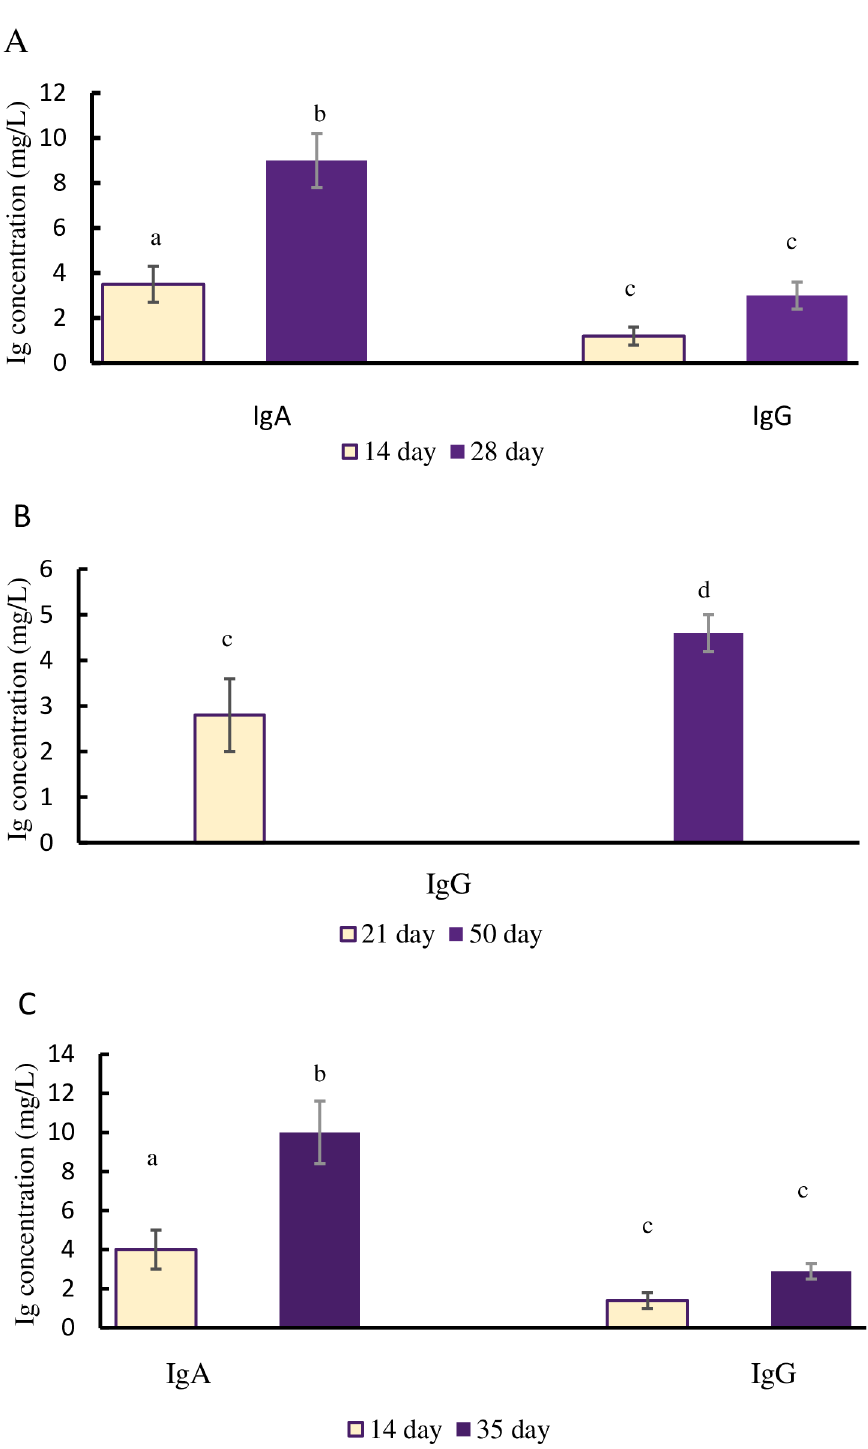
Fig 4. The immune response in mice after vaccination with live vaccine. Mice were vaccinated vaginally (A), per os (B) nasally, (C) with E . faecium L3Bac +. The Bac-specific secretory IgA and/or serum IgG levels were measured after vaccination. Each point on the chart represents the average value from 10 measurements. In controls, the concentration of specific mucosal IgA and serum IgG did not exceed 3 mg/L. Means with different letter differ significantly (p < 0,05). Symbols a-b are valid for IgA, c-d for IgG.